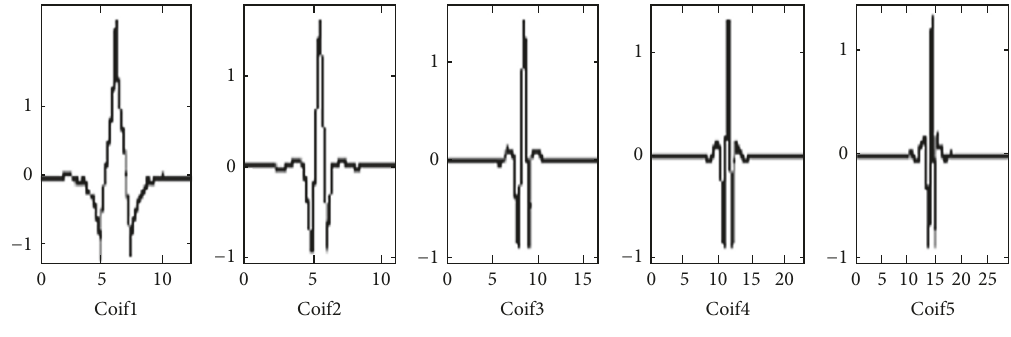
Figure 3: Coiflet wavelet families [16].